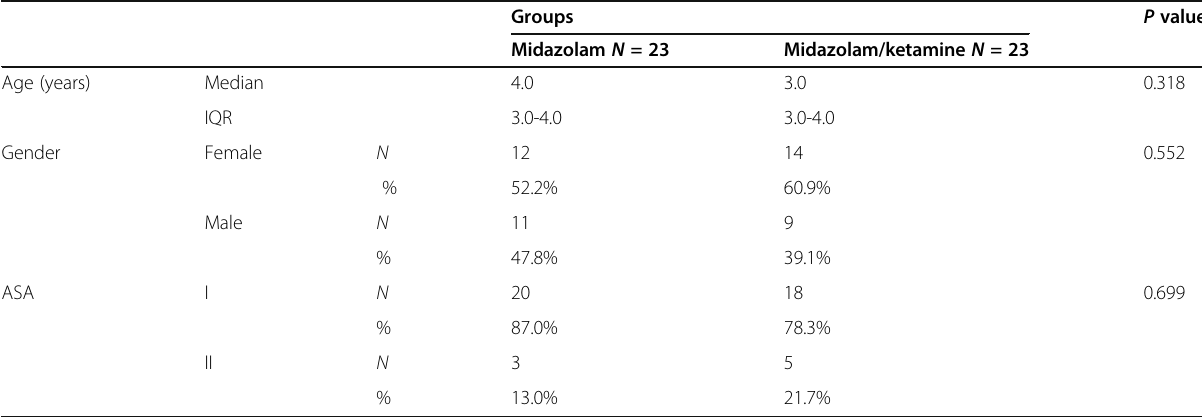
Table 1 Baseline characteristics of the studied groups